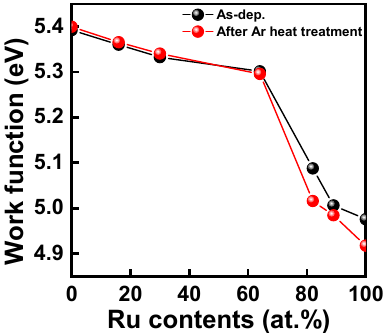
Figure 4. Work functions of PtRu bimetallic alloy thin films according to the film compositions before and after Ar heat treatment at 700 °C.